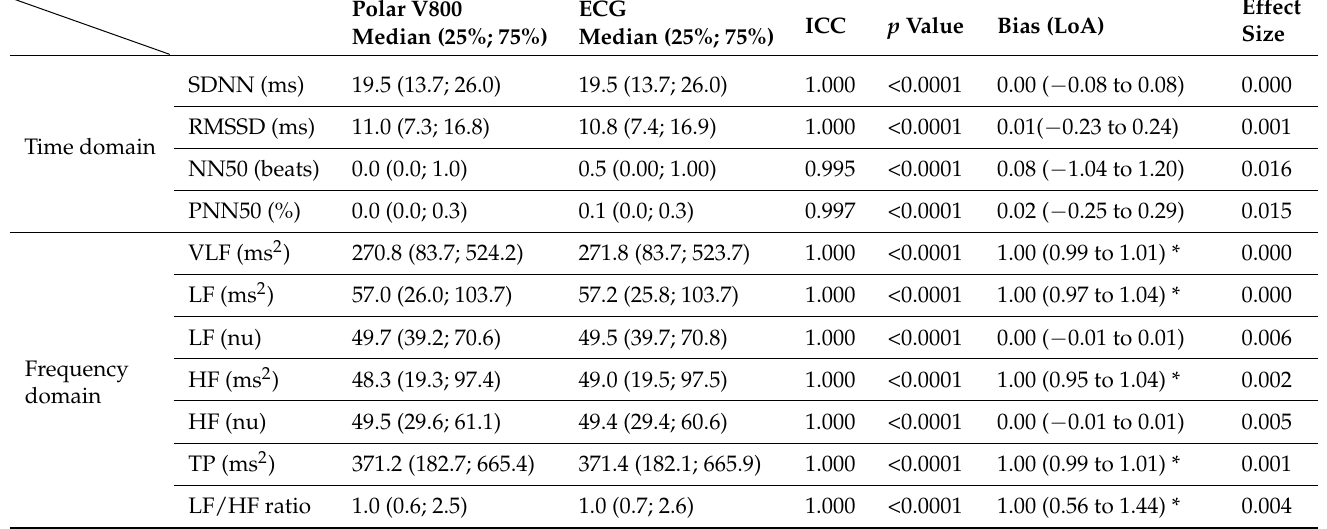
Table 7. HRV parameters for mental arithmetic test at SSWV.